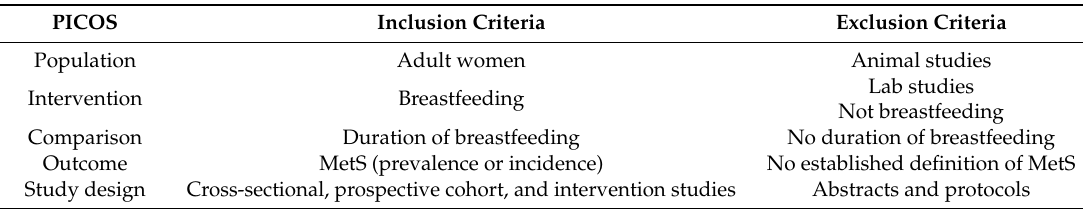
Table 1. Inclusion and exclusion criteria.